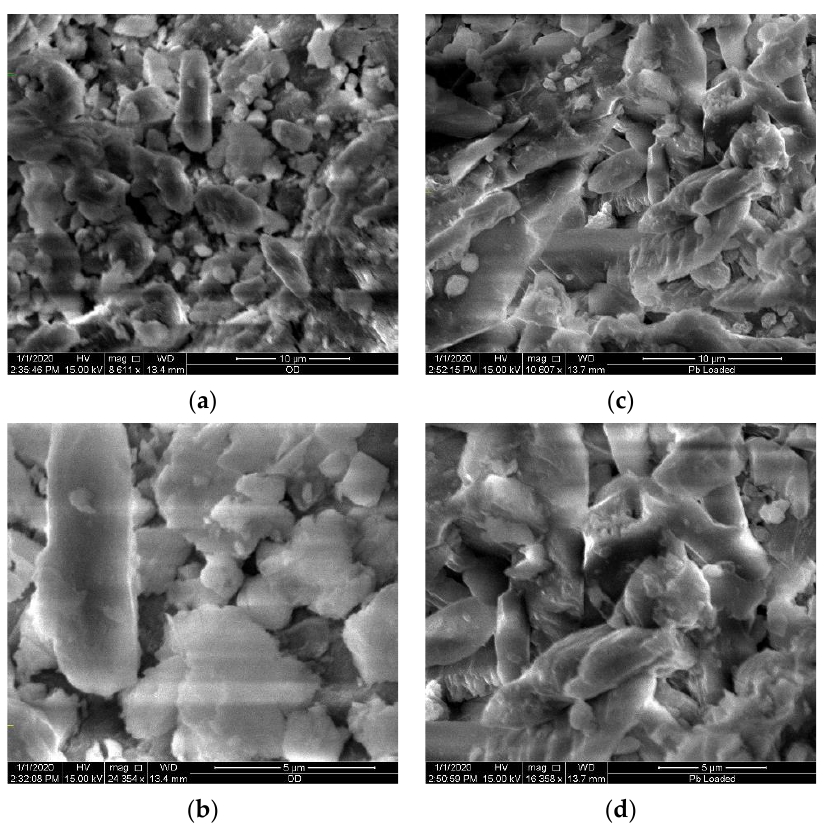
Figure 1. SEM images of Odaracha adsorbent before ( a , b ) and after adsorption ( c , d ) of lead.